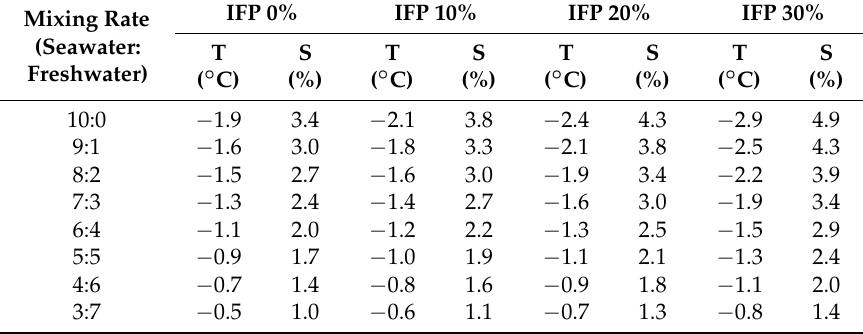
Table 1. Freezing point and salinity according to mixing rate and ice packing factor (IPF)